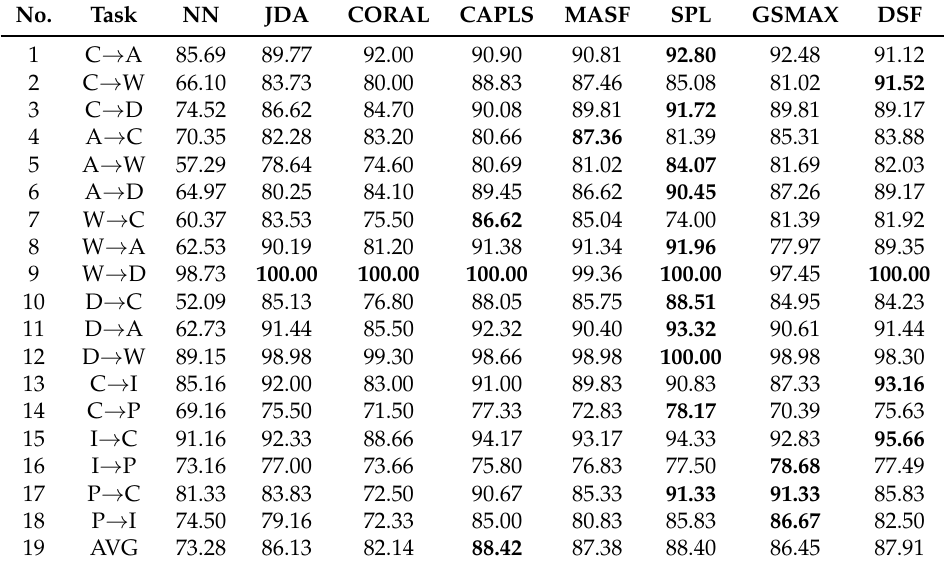
Table 2. Performance (accuracy %)on Office-Caltech10 (No.1-12) and ImageCLEF (No.13-18).